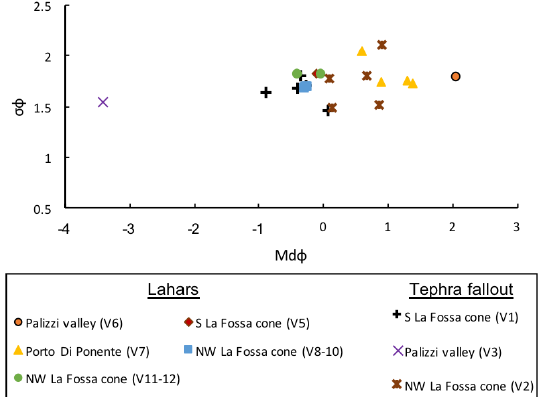
Figure 5. Md (cid:56) vs. σ(cid:56) diagram for the lahar matrix and tephra fall- out deposits. Porto Di Ponente (orange triangle) corresponds to the following samples: V7-1, V7-2, V7-3, V7-4 S (Fig. 4c). The La Fossa cone V1 (black cross): V1A, V1B, V1C, V1D, V1E (Fig. 3c). NW La Fossa cone V2 (brown star): V2A, V2B, V2C, V2D, V2E (Fig. 3d).